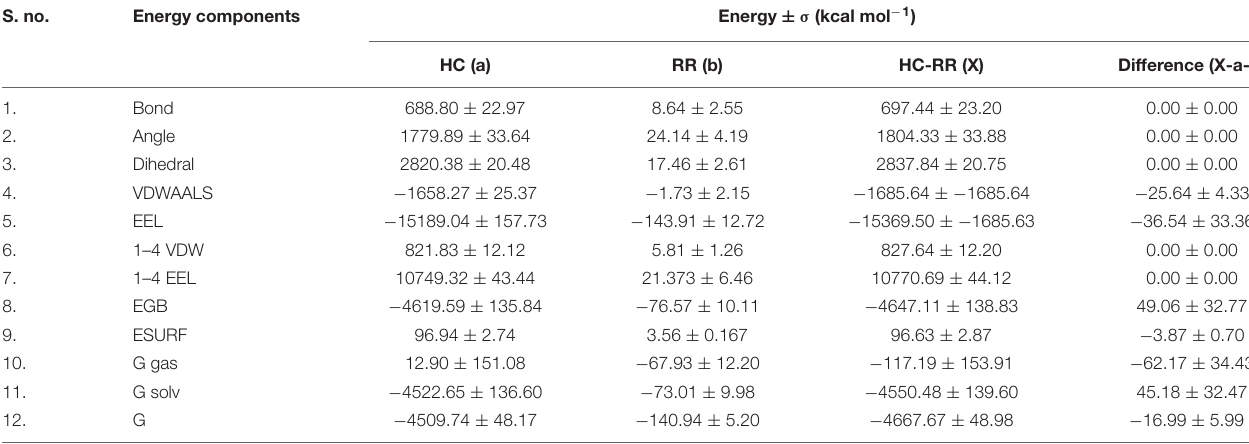
TABLE 2 | Molecular mechanical energies combined with the generalized born and surface area continuum salvation (MMGBSA) calculation for the HC–RR complex. S.